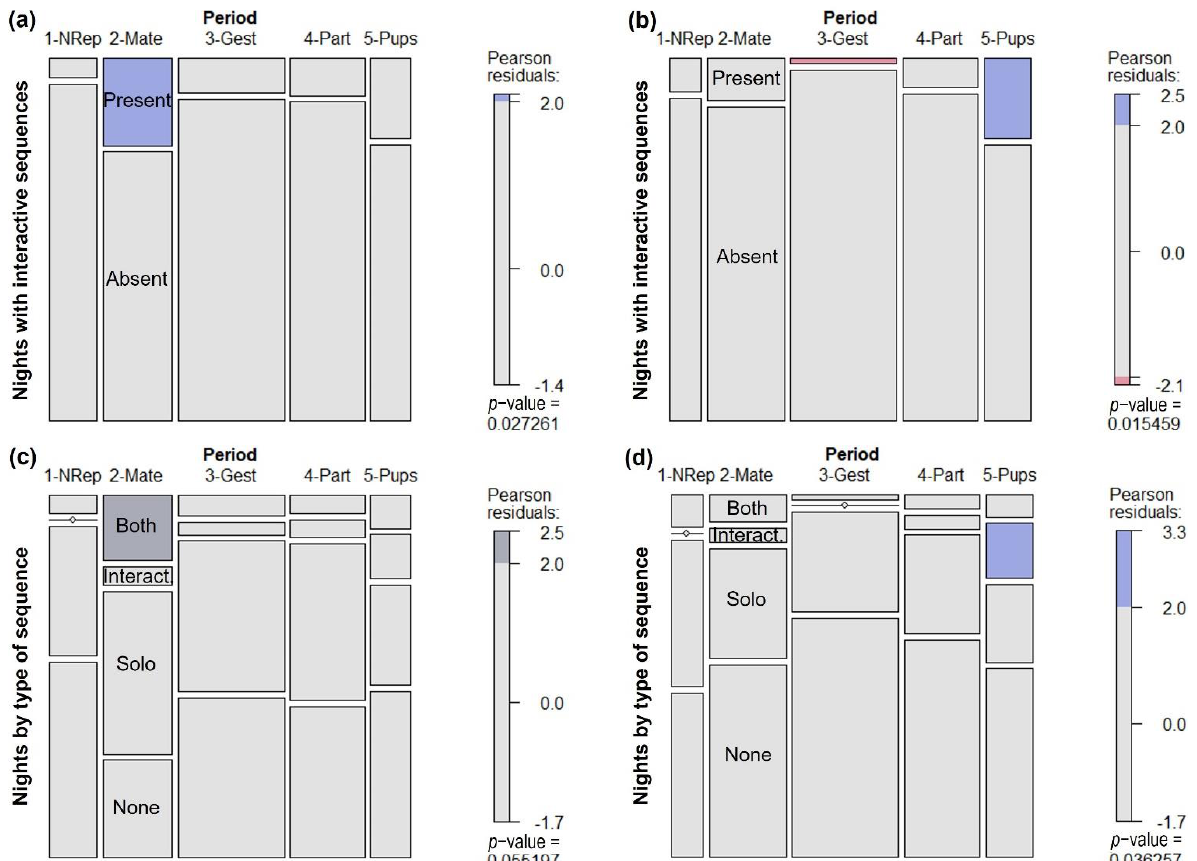
Figure 6. Mosaic plots showing the proportion of nights in each roar-bark activity category through time. Each mosaic tile area is proportional to the observed number of nights in each category (height) and the number of nights sampled in each time period (width). Time periods are as follows: NRep = non-reproductive; Mate = mating; Gest = gestation; Part = parturition; and Pups = initial parental care. Pearson residuals were used in a Chi-Square Test of Independence to verify if there is a difference among observed and expected values. Blue tiles have significantly greater frequency values than expected, dark grey tiles have greater frequency values than expected, but marginally significant, and red tiles have significantly smaller frequency values than expected. All other tiles show no significant difference among observed and expected values. ( a ) Proportions of nights with and without interactive roar-bark sequences using the entire dataset; ( b ) Proportions of nights with and without interactive roar-bark sequences using the subsampled dataset considering only the 5 recorders common to all periods; ( c ) Proportion of each category of vocal activity using the entire dataset; ( d ) Proportions of each vocal activity category using the subsampled dataset considering only the 5 recorders common to all periods. Categories of vocal activity are as follows: None = no vocal activity; Solo = only solo roar-bark sequences; Interact. = only interactive roar-bark sequences; and Both = solo and interactive sequences. Plots made in R with function mosaic {vcd}.